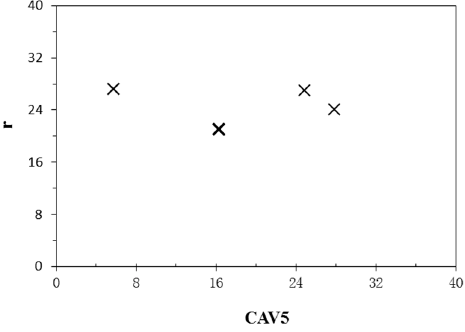
Figure 5. r versus CAV 5 for 7 ≤ M w ≤ 7.9 of the main dataset applied in this study.